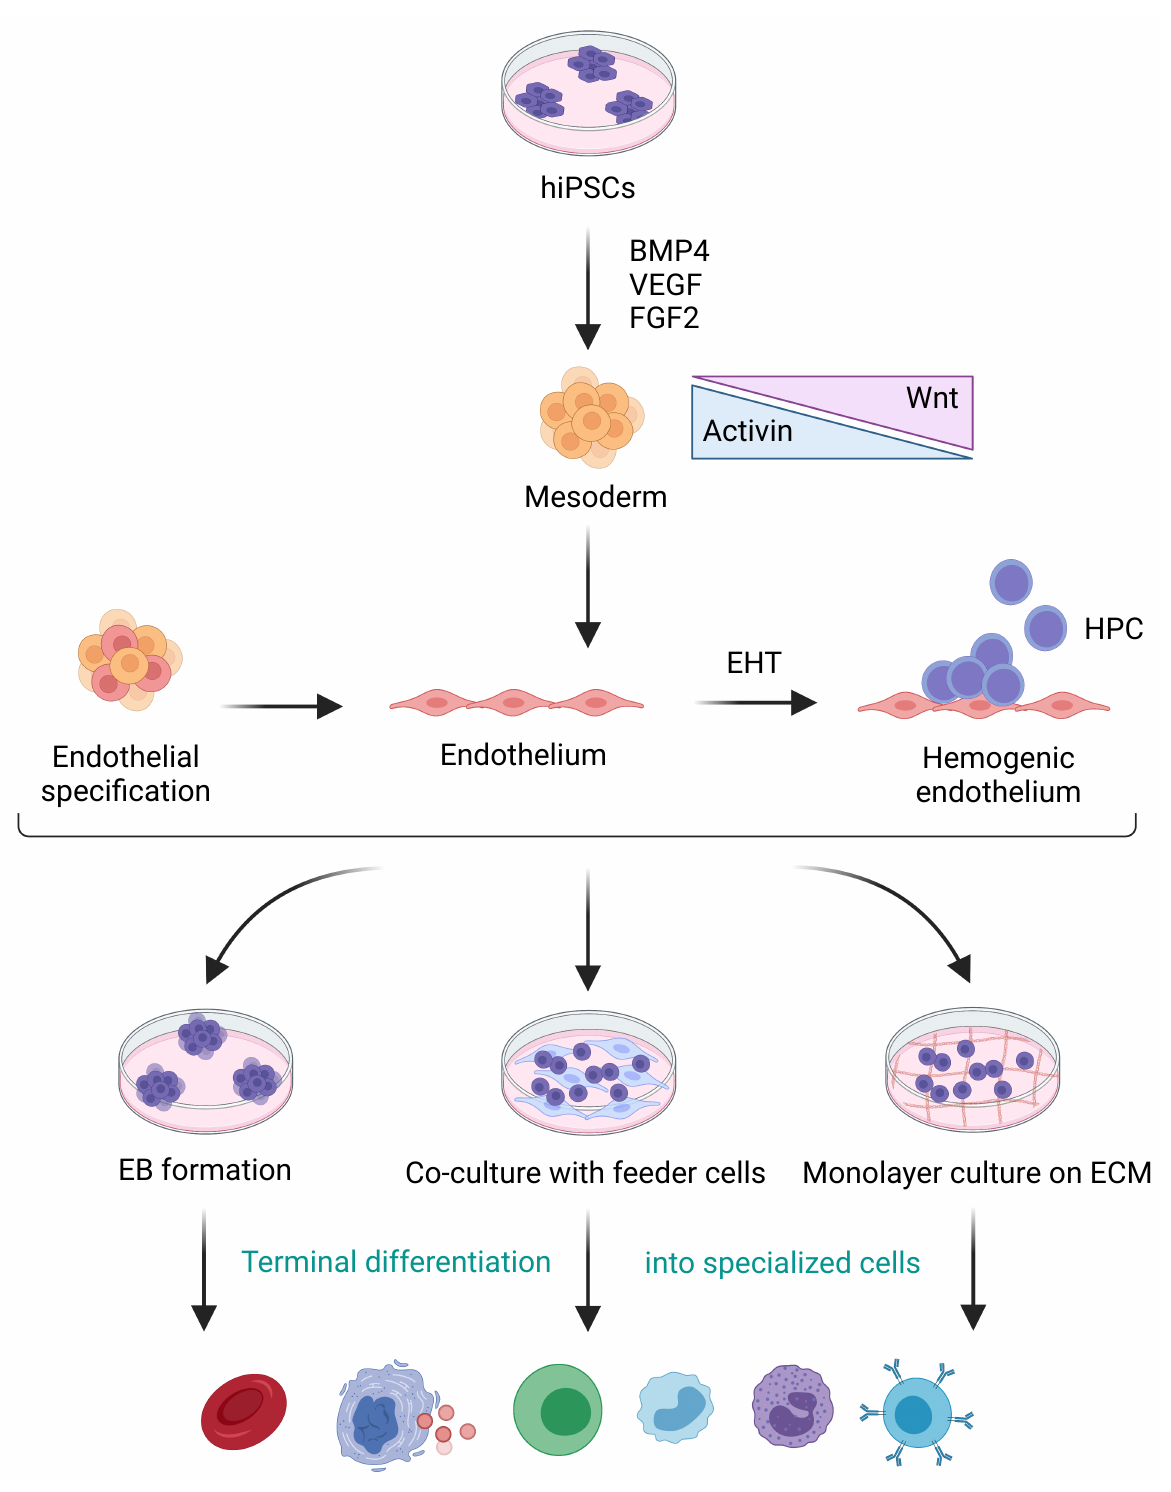
Figure 2. In vitro hematopoietic differentiation from hiPSCs via mesoderm induction. hiPSC, human induced pluripotent stem cell; BMP4, bone morphogenetic protein 4; VEGF, vascular endothelial growth factor; FGF2, fibroblast growth factor 2; EHT, endothelial-to-hematopoietic transition; HPC, hematopoietic progenitor cell; EB, embryoid body; ECM, extracellular